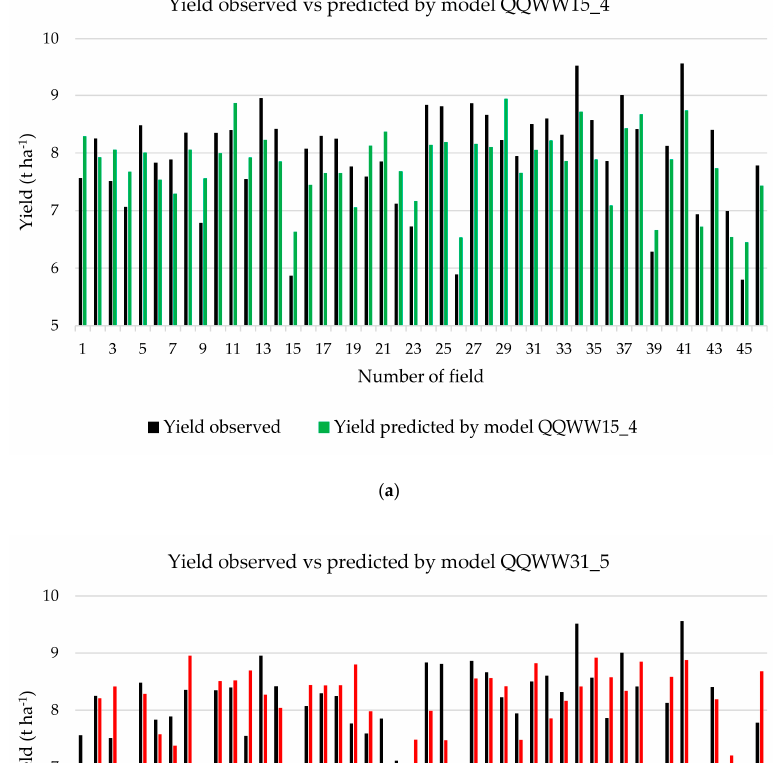
Table 5. Sensitivity analysis of neural networks.